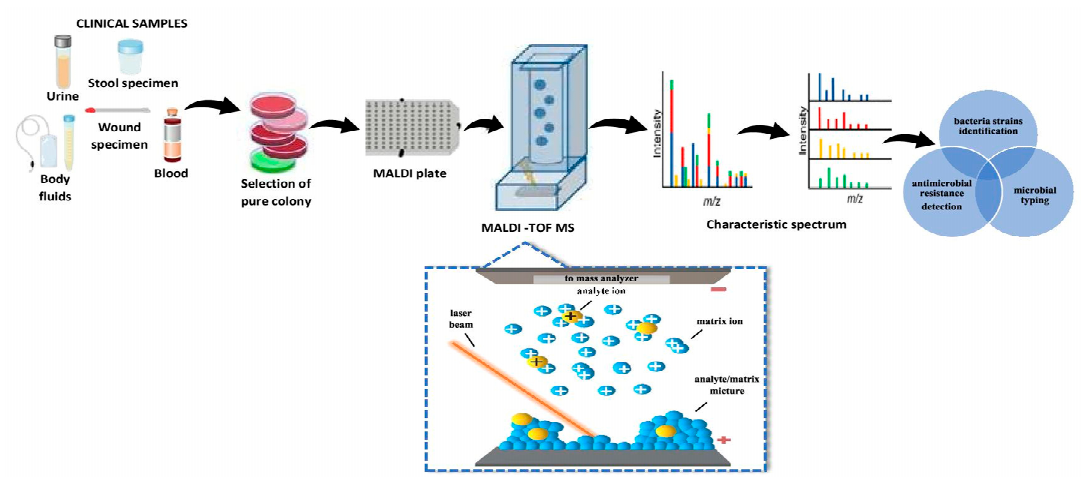
Figure 8. Schematic illustration of MALDI-TOF MS (matrix-assisted laser desorption/ionization with time of flight) analysis.